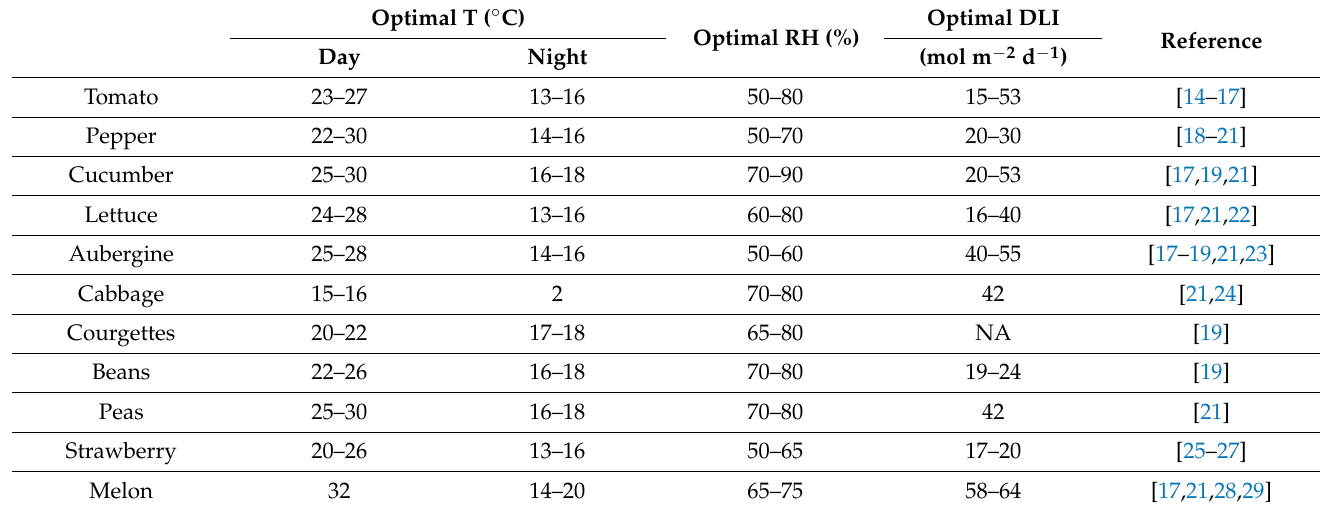
Table 1. Climate requirements for selected greenhouse crops in hot and arid